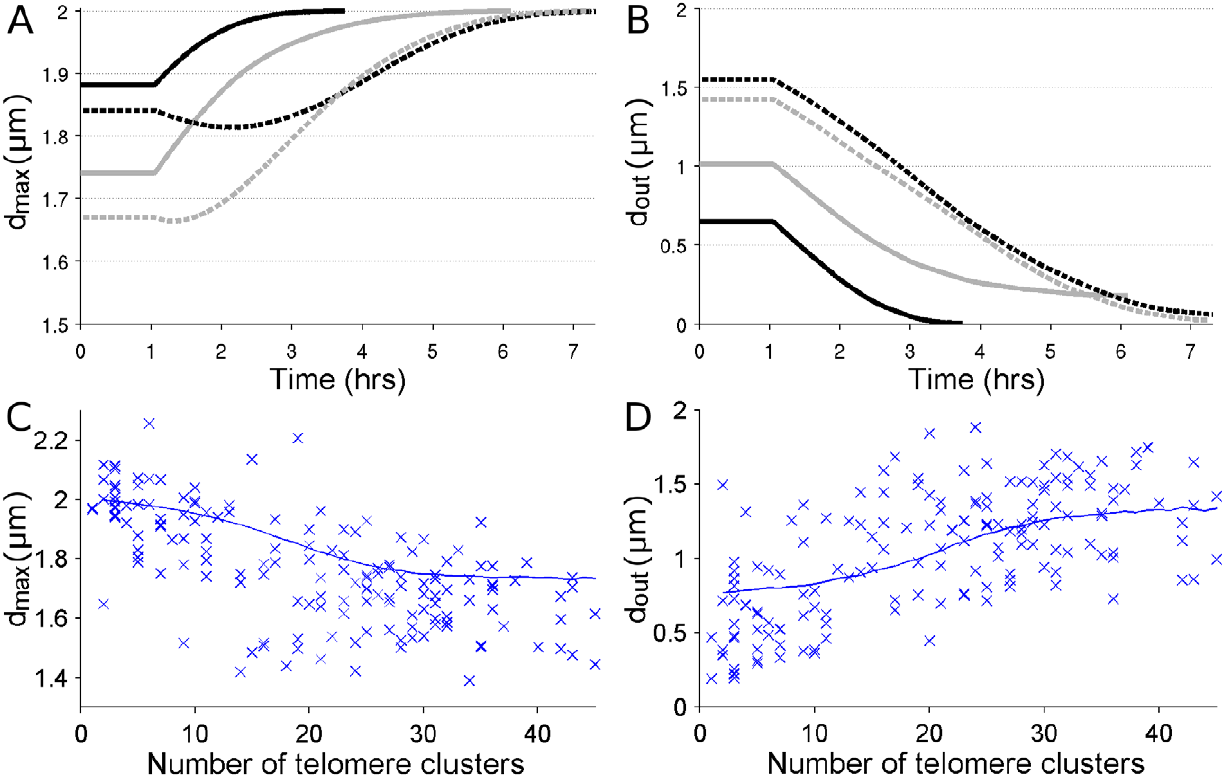
Figure 6. Examples of how d max and d out change with time, and experimental scatter plots (compared to the deterministic pure- drift model) of how d max and d out vary with the number of telomere clusters. A. Four examples of how d max changes with time in the deterministic pure drift model with a randomly-orientated initial cap. As telomere clusters move towards the bouquet site, d max generally increases attaining a maximum of 2 R when the bouquet is fully formed. The initial plateau represents the initial waiting time T 0 . Cases where d max initially decreases correspond to the initial cap partially occurring in the inside hemisphere (i.e. the hemisphere opposite the bouquet site). B. The same four examples but showing how d out changes with time. In contrast to d max , d out decreases as the bouquet forms, reaching a minimum upon bouquet completion. The theoretical minimum ( d out =0) is only attained if the bouquet site is directly opposite the centre of the anther. C. Maximum average telomere cluster distance (as a fraction of the nuclear radius), d max , against the number of telomere clusters, N , for Ph1 2 meiocytes. D. Average telomere cluster distance to outside pole (as a fraction of the nuclear radius), d out , against the number of telomere clusters, N , for Ph1 2 meiocytes. The blue lines show the average values of d out and d max given by the deterministic pure-drift model.